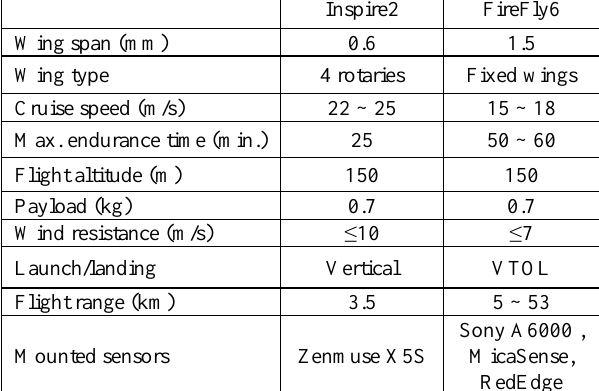
Table 1. Specifications of small UAVs used in this study